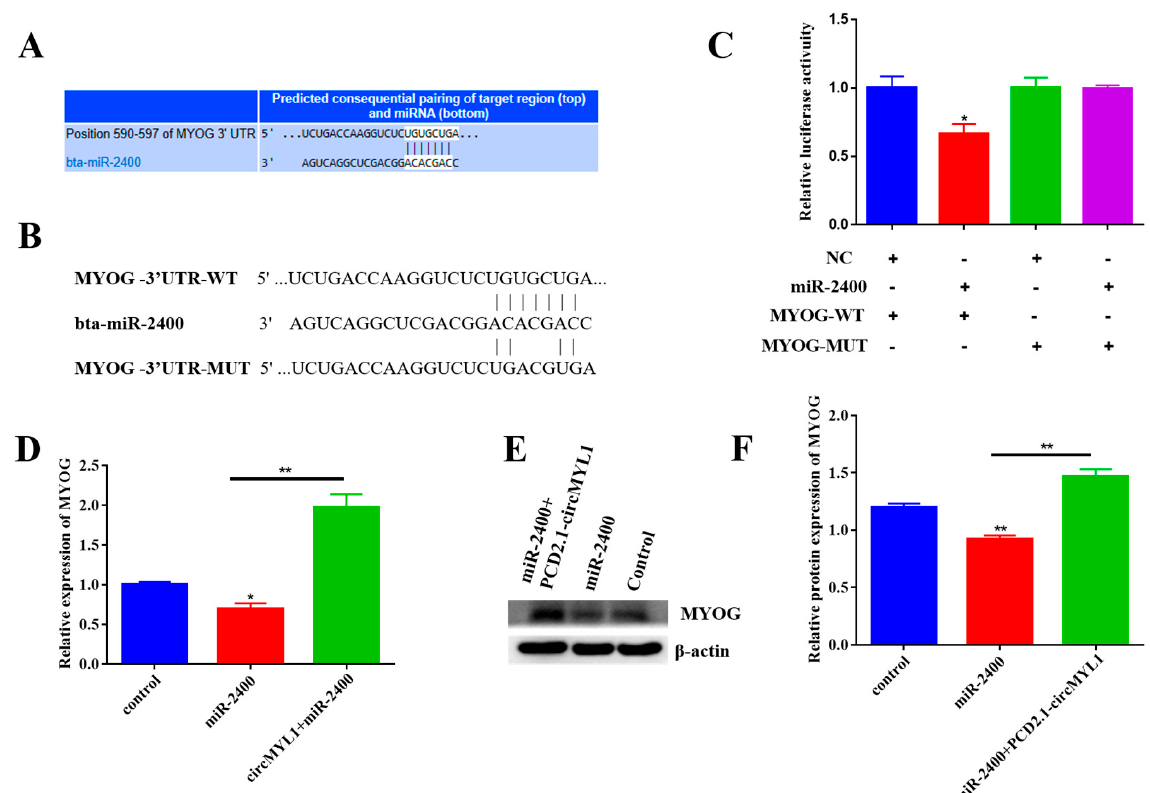
Figure 8. circMYL1 acts as a ceRNA for miR-2400 to activate MYOG ( A ) TargetScan 7.2 predicted the potential binding site of miR-2400 in the MYOG-3 (cid:48) -UTR. ( B ) The sequence of miR-2400 and its predicted binding site in the MYOG 3 (cid:48) -UTR and mutated 3 (cid:48) -UTR. ( C ) Luciferase assay was conducted after co-transfected the miR-2400 mimic or negative control into HEK293 T cells with the MYOG-WT or MYOG-MUT. The activity of renilla luciferase was normalized for the activity of firefly luciferase. ( D ) qRT-PCR detected the relative expression levels of MYOG in bovine primary myoblasts after transfected with miR-2400 mimic and/or circMYL1 overexpression vector. ( E ) Western blot analysis detected the protein expression levels of MYOG in bovine primary myoblasts after transfected with miR-2400 mimic and/or circMYL1 overexpression vector. ( F ) Histogram graph showing the protein band density evaluated using ImageJ. Data are shown as mean ± SEM. n = 3. * p < 0.05; ** p <